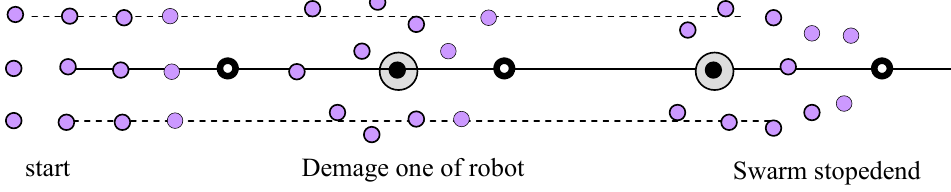
Figure 23. The effects of a robot fault on the swarm array.